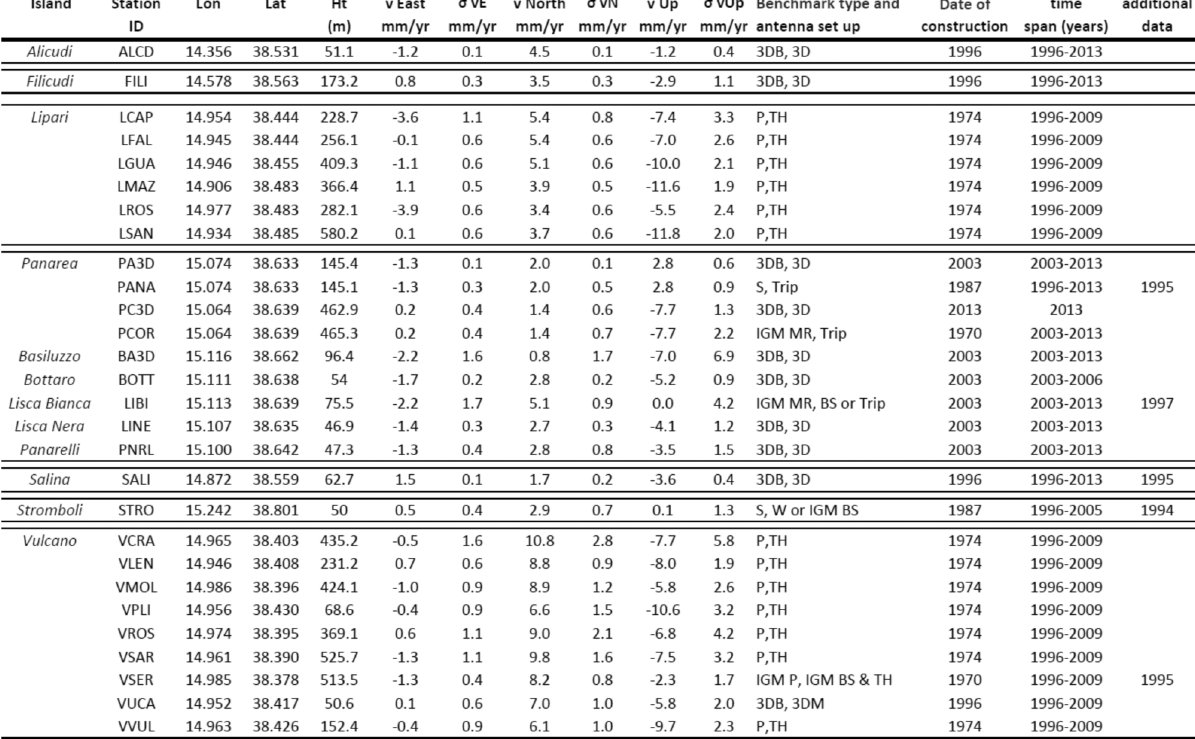
Table 2. Velocities and uncertainties (in mm/yr -1 ) of the GPS benchmarks. Station name and ID; coordinates; ITRF2008 velocities with re- spect to Eurasia at 1 v confidence level; benchmark type and antenna set up mode; date of construction of the benchmark; time span of GPS data reported in the open access archive; additional GPS data. See text for further